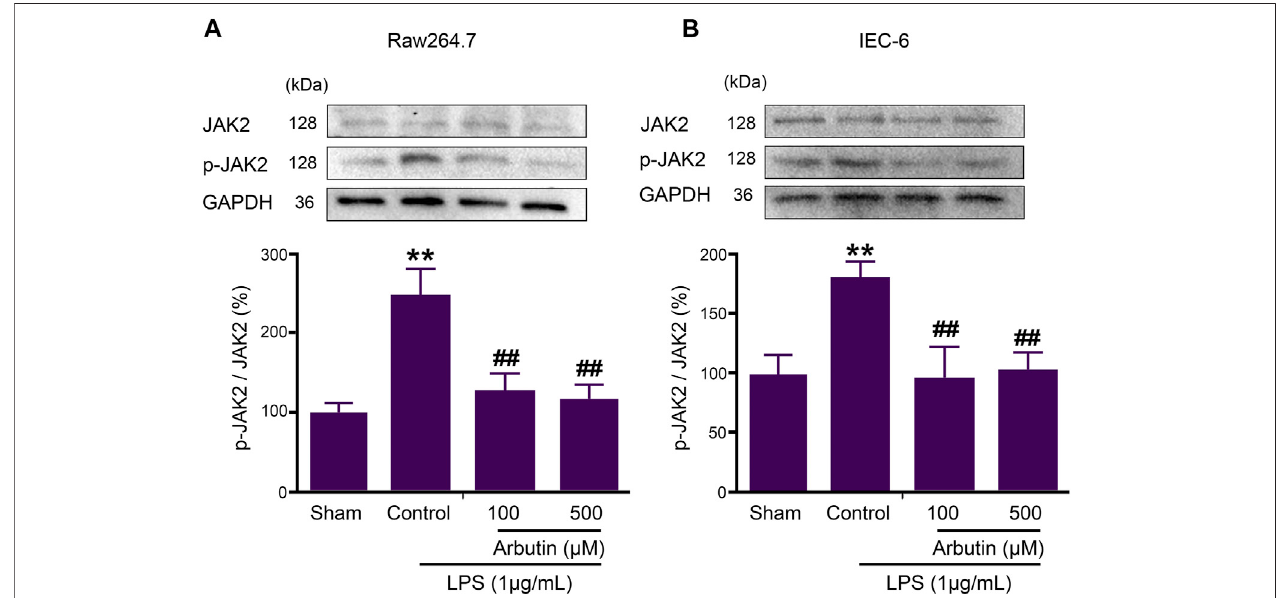
FIGURE 6 | Arbutin inhibited JAK2 signaling pathway in LPS-stimulated IEC6 and RAW264.7 cells. The proteins associated with the JAK2 pathway were determined in cell lines. RAW 264.7 cells (A) and IEC-6 cells (B) were treated with arbutin (100 and 500 μ M) for 12 h after treatment with LPS (1 μ g/ml) for 12 h, and the expression levels of JAK2, and p-JAK2 were investigated by Western blot analysis. Data were expressed as mean ± SD. ** p < 0.01 compared with sham group; ## p < 0.01 compared with LPS control group.